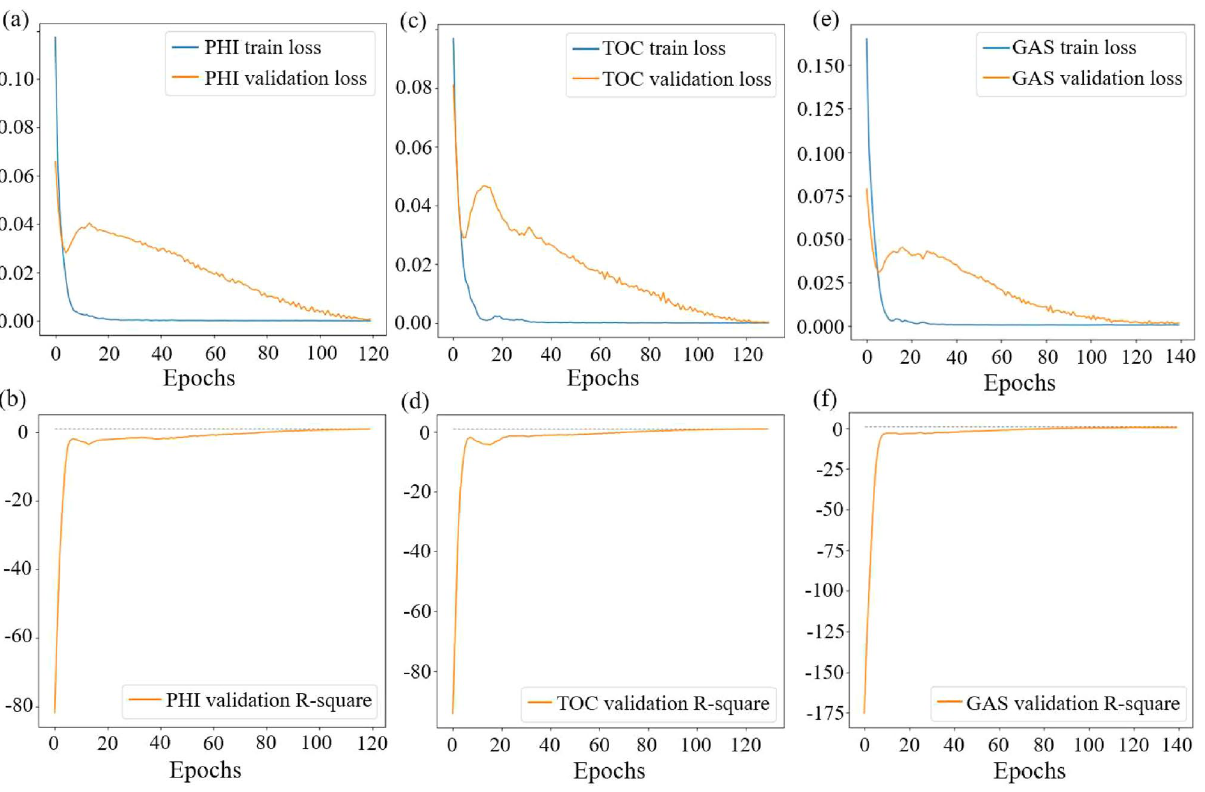
Figure 8. Training curves of PHI, TOC and GAS predict